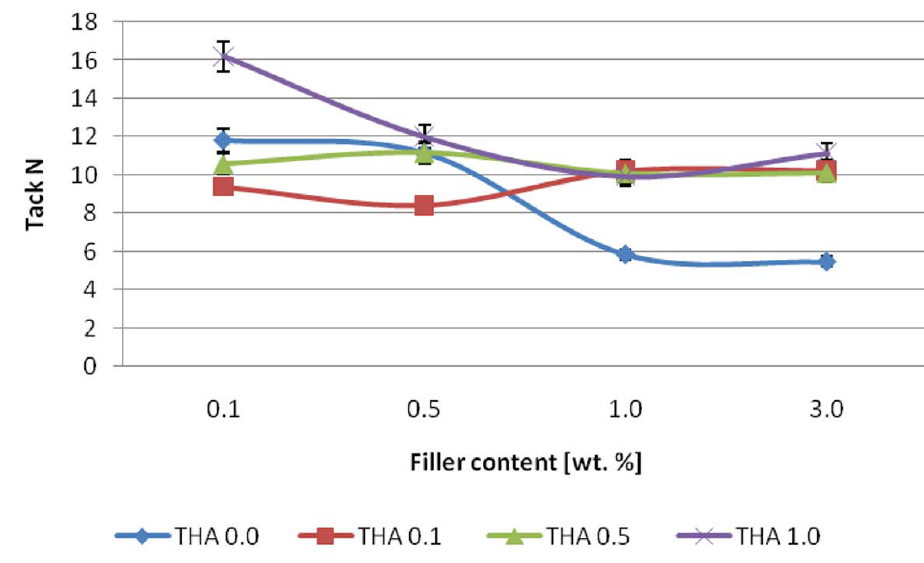
Figure 5. Effect of neat and modified illite on the tack of silicone pressure-sensitive